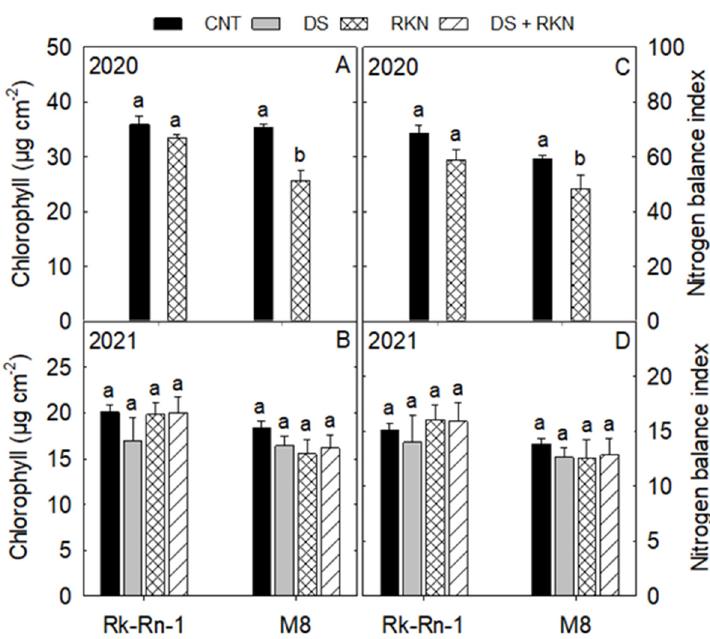
Figure 1. Drought and nematode effects on chlorophyll content ( A , B ) and nitrogen balance index ( C , D ) of cotton genotypes (Rk-Rn-1 and M8) measured under control (CNT), drought stress (DS), nematode stress (RKN), and DS + RKN combination in 2020 ( A , C ) and 2021 ( B , D ). Vertical bars denote mean ± SE. Means followed by a common letter are not significantly different by Duncan’s multiple range test at the 5% level of significance.